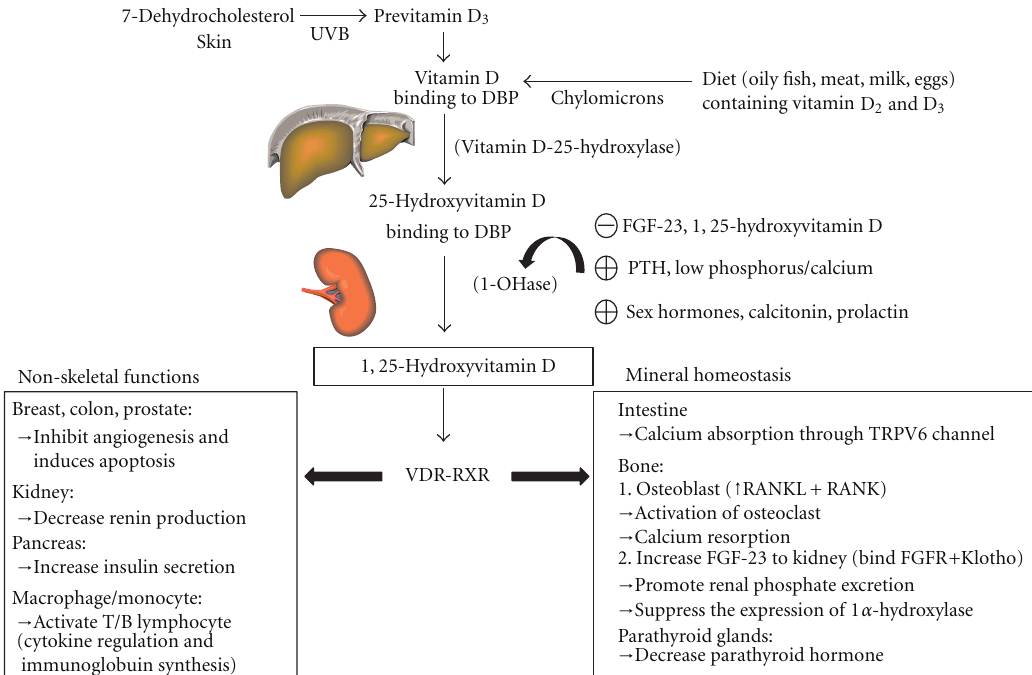
Intestine → Calcium absorption through TRPV6 channel Bone: 1. Osteoblast ( ↑ RANKL+ RANK) → Activation of osteoclast → Calcium resorption 2. Increase FGF-23 to kidney (bind FGFR+Klotho) → Promote renal phosphate excretion → Suppress the expression of 1 α -hydroxylase